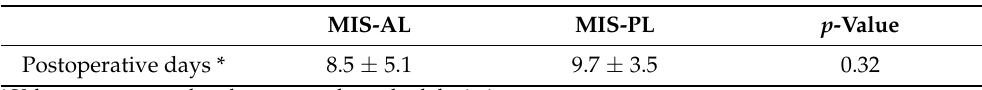
Table 4. Postoperative days wherein patients were capable of walking for more than 150 m with a single assistance walking